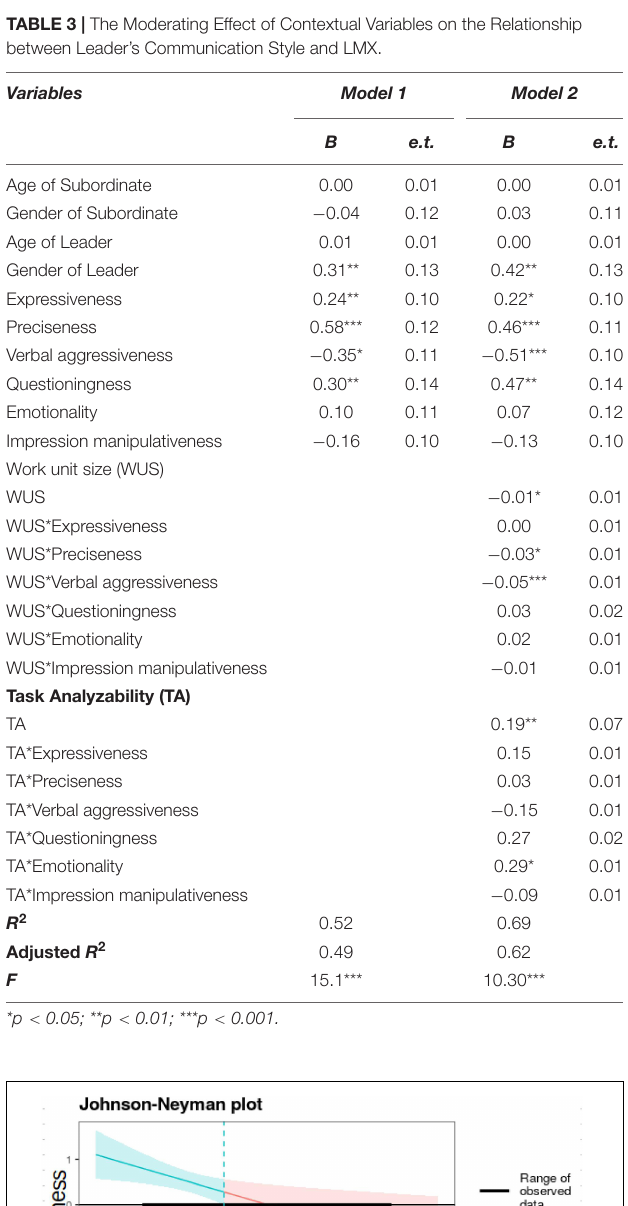
uphold the system’s privileges, status symbols, and prevalence of those “at the top.”